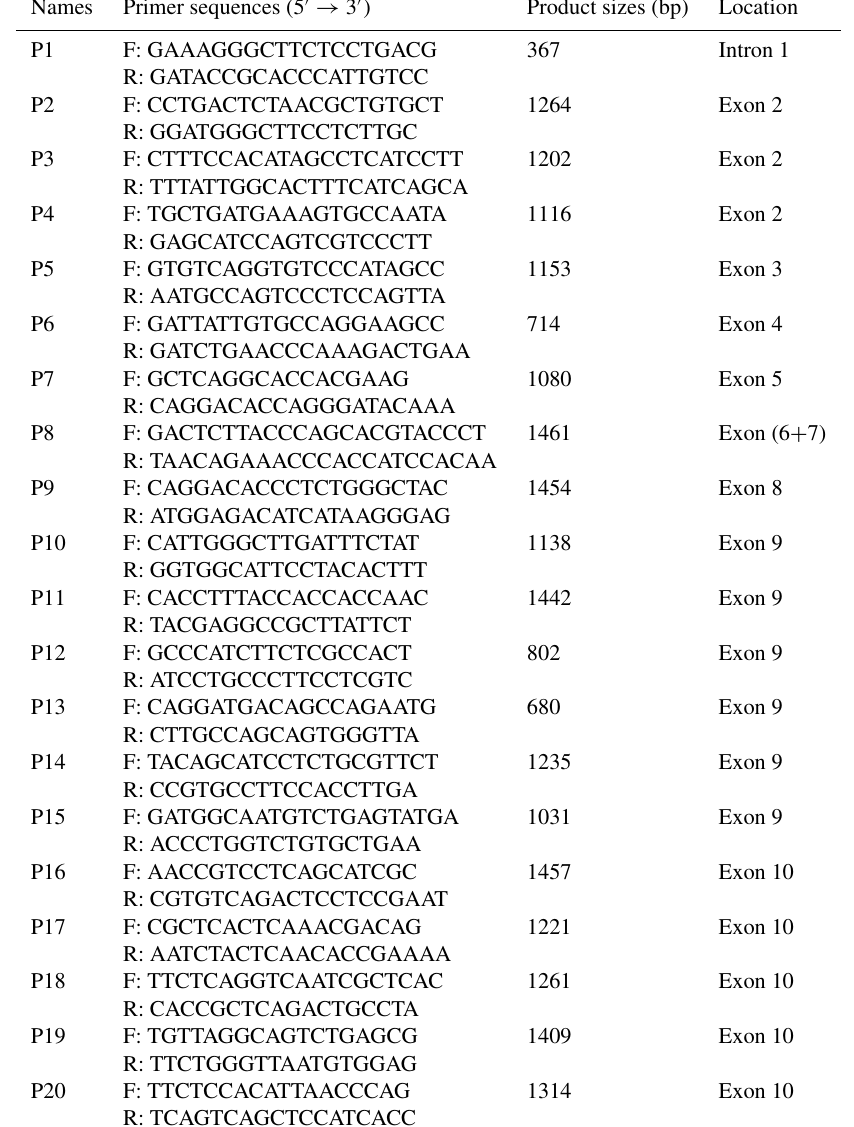
Table 1. Amplification PCR primers for screening the novel SNPs within the bovine ATBF1 gene; bp: base pair. Names Primer sequences (5 (cid:48) → 3 (cid:48) ) Product sizes (bp) Location 367 Intron